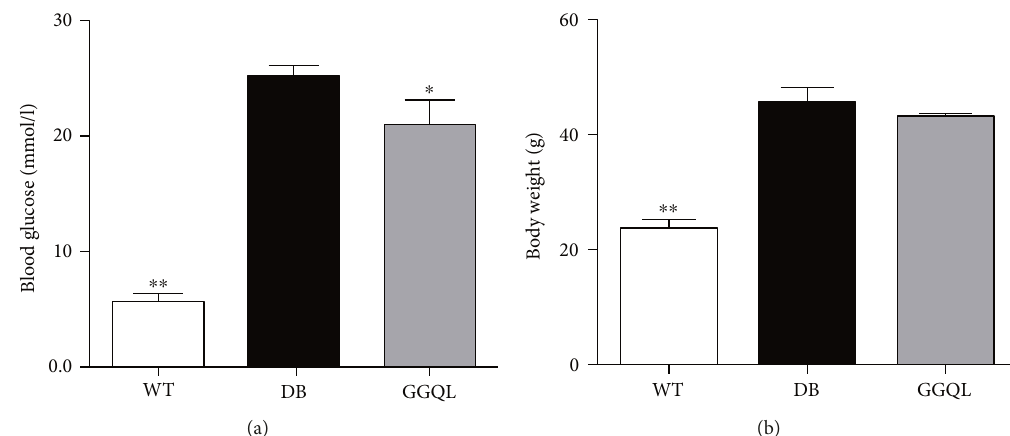
Figure 1: The results of blood glucose and bodyweight. (a) Blood glucose and (b) bodyweight in each group ( n = 8 ). The DB group was the reference group to calculate P values, ∗ P < 0 05 and ∗∗ P < 0 01 .